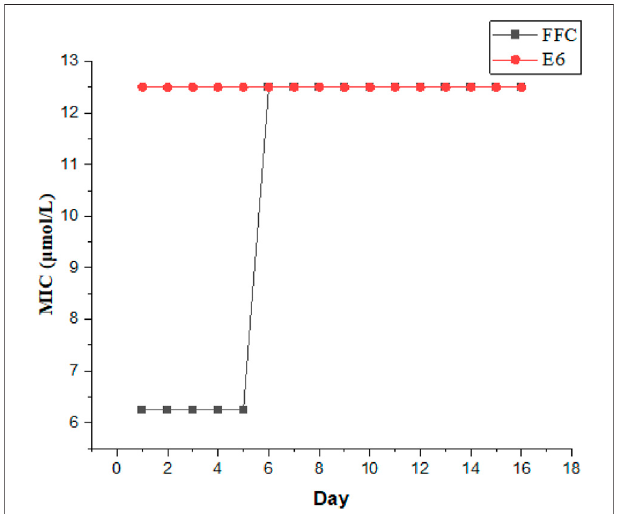
FIGURE 3 | Propensity of E. coli resistance against conjugate E6. the control was FFC.